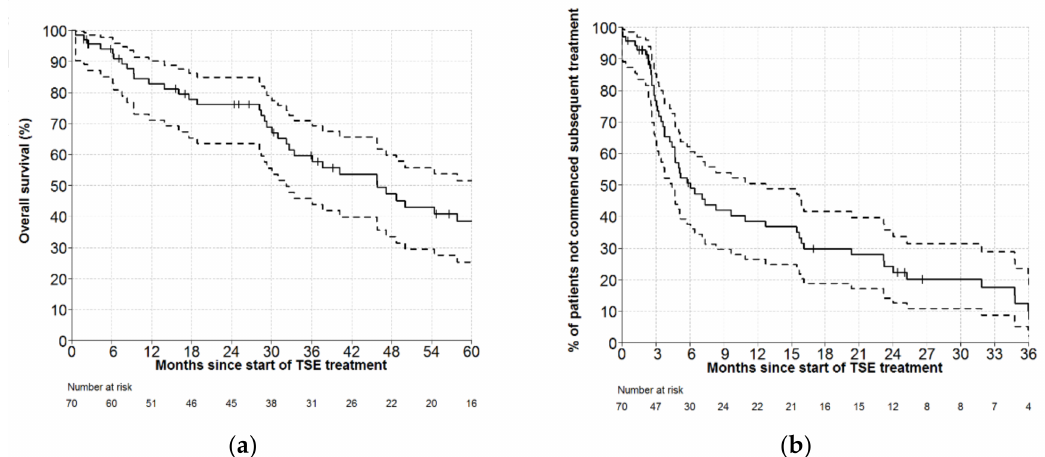
Figure 1. ( a ) Overall survival following conventional-dose total skin electron therapy (TSE) for the whole cohort. Dashed lines represent the 95% confidence interval. ( b ) Time to next treatment following conventional-dose total skin electron therapy (TSE) for the whole cohort. Dashed lines represent the 95% confidence